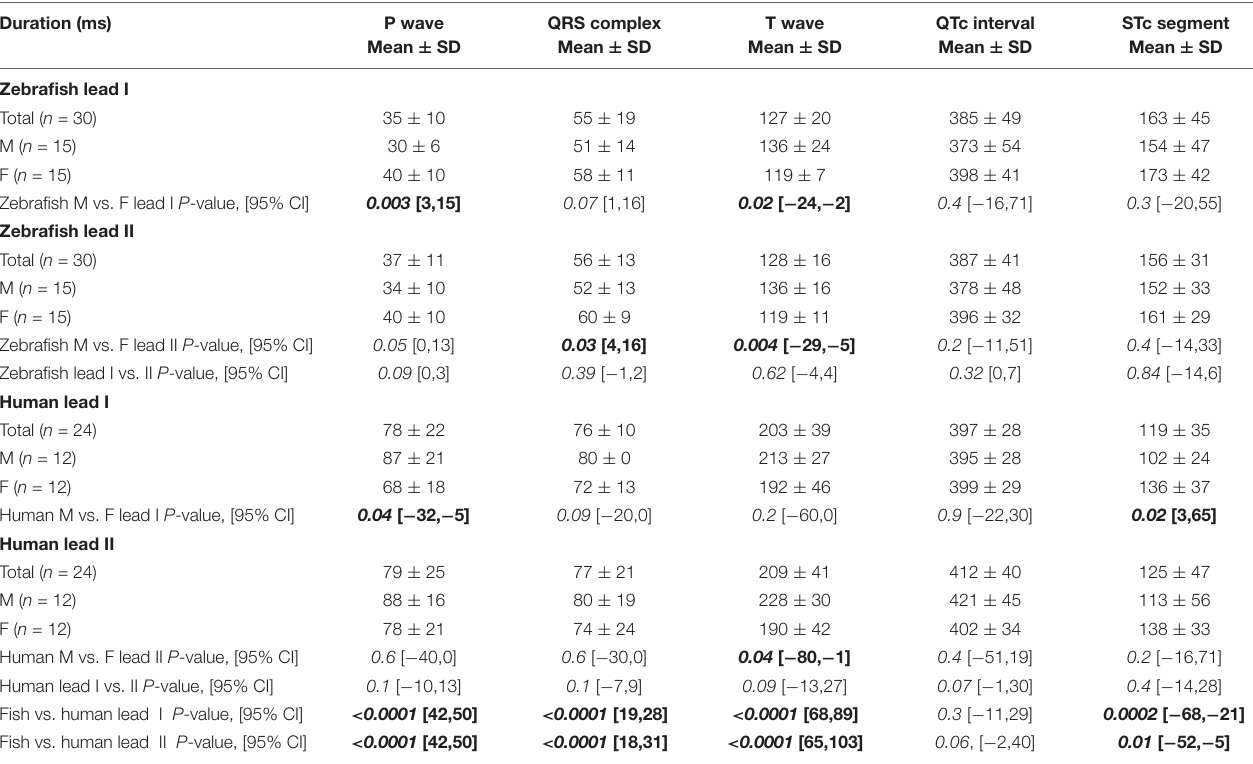
TABLE 1 | Duration of ECG components on Einthoven leads in zebrafish vs. humans. Duration